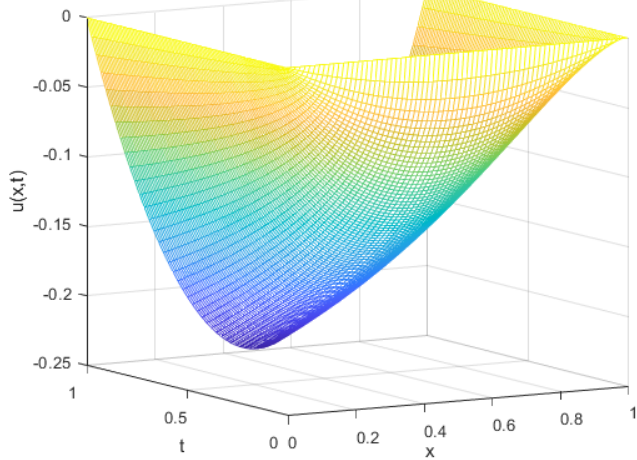
Figure 7. HASC-N scheme solution surface for Example 2. ( α =